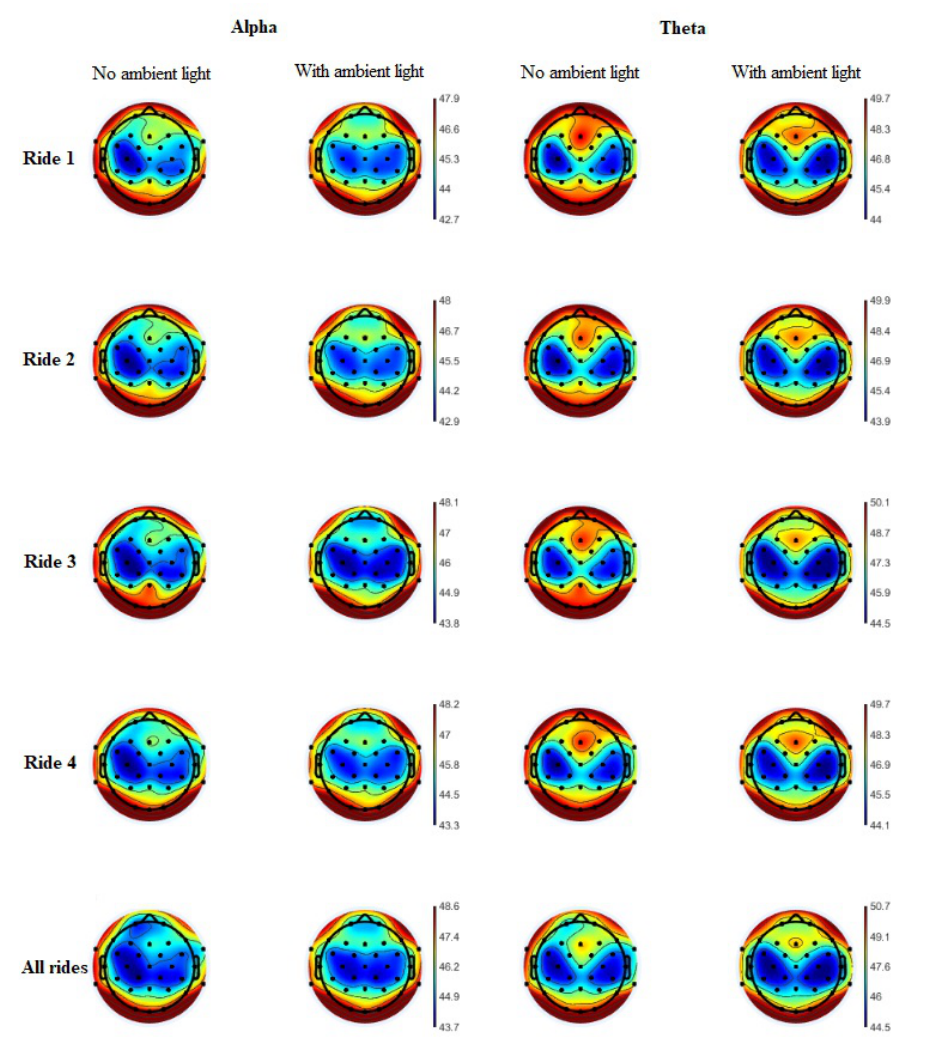
Figure 3. Averaged topography over the alpha (8–13 Hz) and theta (4–8 Hz) frequency range.